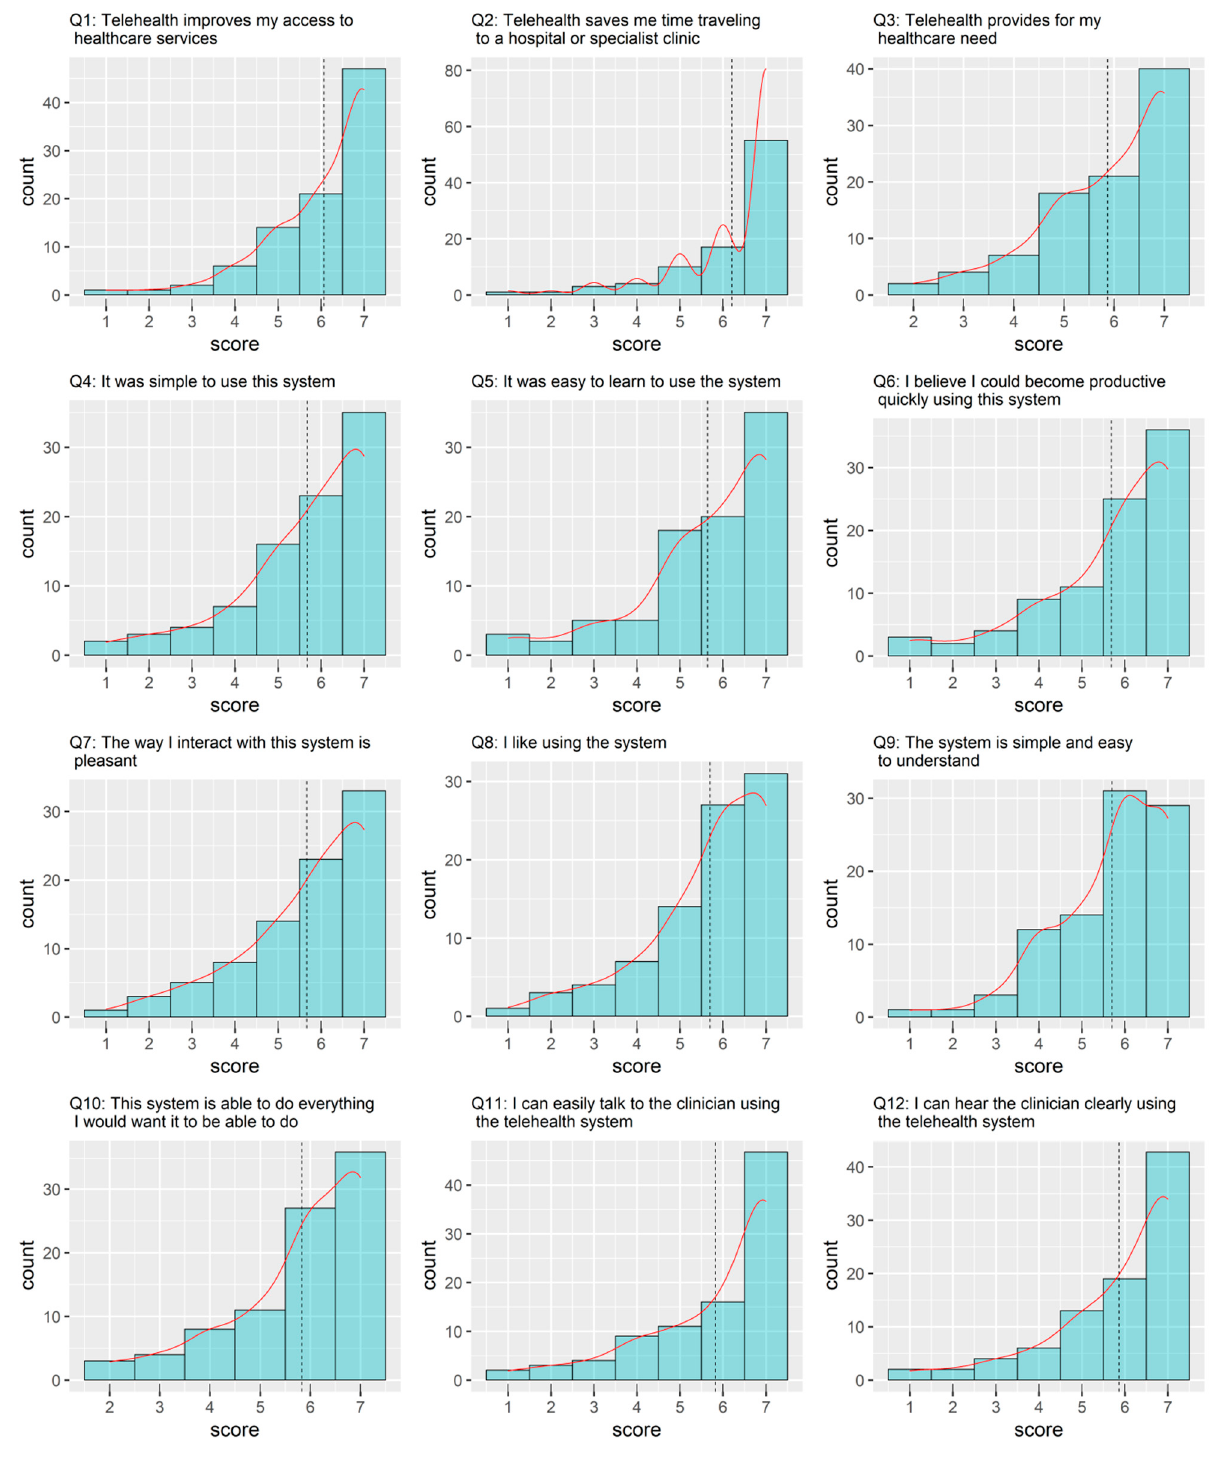
Figure 3. Patient satisfaction questionnaire (items 1–12). The questions were answered using a 7-point Likert scale (i.e., from “strongly disagree” = 1, to “strongly agree” = 7). The dashed lines indicate the mean values.